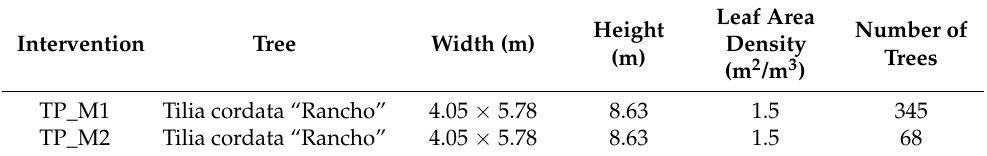
Table 9. Settings for the tree species in the case of the tree planting intervention (TP). Intervention Tree Width (m)